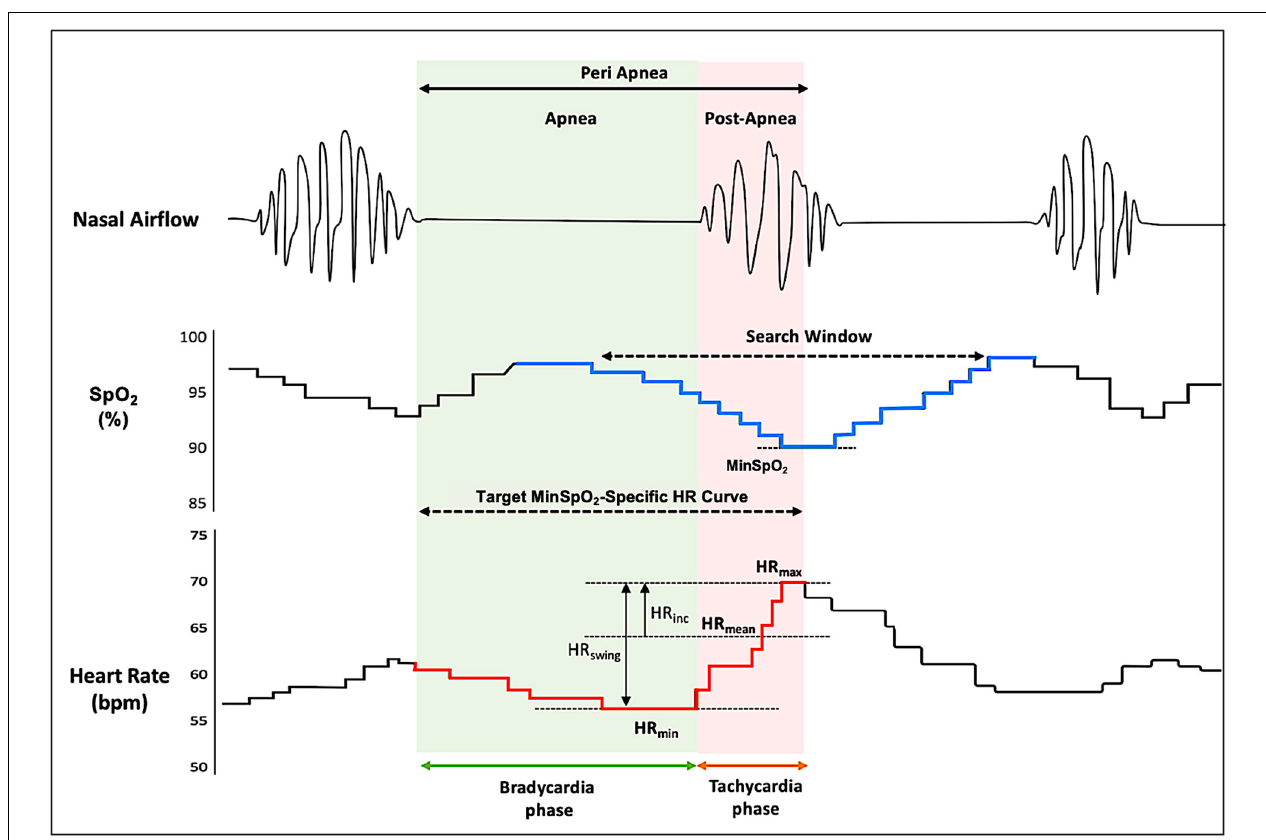
FIGURE 1 | Typical heart rate response during a sleep apneic event. The figure demonstrates a typical pattern of HR tracings (redline, lower) during the peri-apnea phase, with a synchronized timescale illustrating oxygen saturation (SpO 2 ) curve (blue line, middle) and nasal airflow (upper). The search window was yielded from overlaying respiratory event–associated oxygen desaturation curve (see section “Materials and Methods” for details). The minSpO 2 is identified based on subject-specific search window, and a corresponding target HR response curve is determined. HR, heart rate; HR min , minimal HR during apnea phase that elicits a subsequent minSpO 2 ; HR max , maximal HR in response to minSpO 2 during post-apnea phase; HR mean , mean HR representing the average of the HR max and the HR min ; HR swing , HR swing indicative of the difference between HR max and HR min ; HR inc , the increment of HR from the HR mean during the peri-apneic period; SpO 2 , oxygen